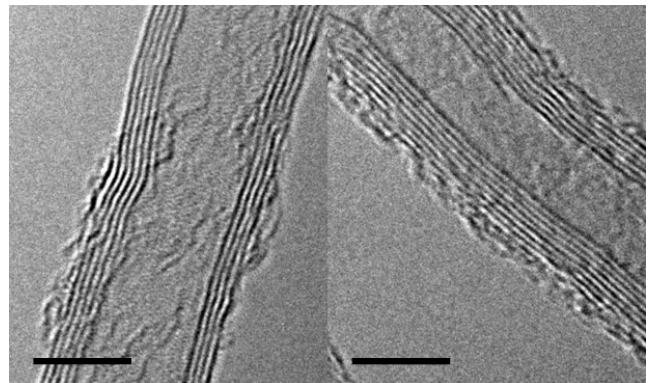
Figure 2. TEM images of the CNTs before (left) and after (right) UV/ozone treatment. Scale bar corresponds to a length of 5 nm. Damage on the outer walls is visible after UV/ozone